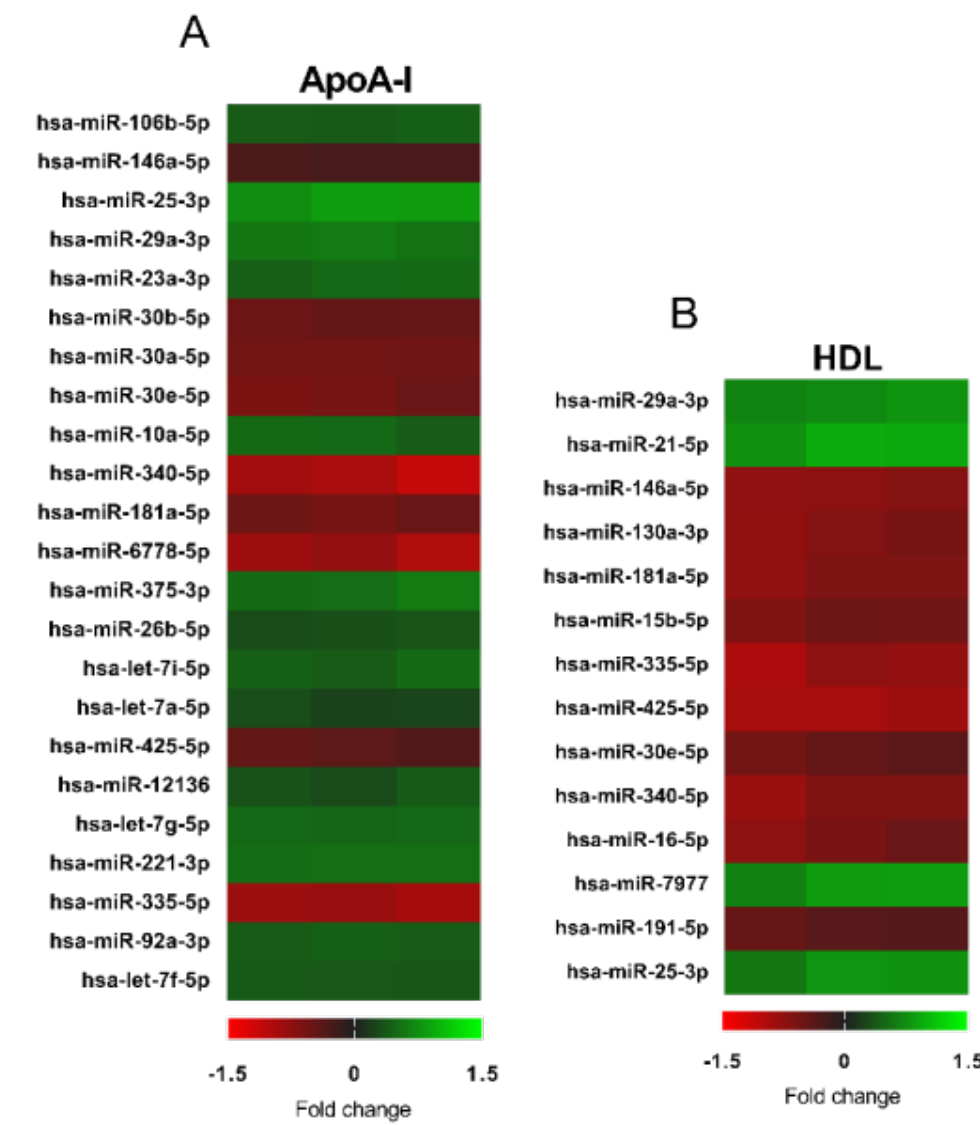
Figure 4. Heatmaps depicting miRNAs that are differentially expressed following a 24 h treatment with 20 µ g mL − 1 .ApoA-I ( A ) or 20 µ g mL − 1 HDL ( B ). Data are presented from 1 sample per group each with an independent microchip array containing three technical replicates per sequence on each microchip. All miRNAs presented show differences p < 0.05 (Students’ t -test) compared to the basal control, and a signal >500. The miRNAs are ranked in order of highly statistically significant miRNAs.